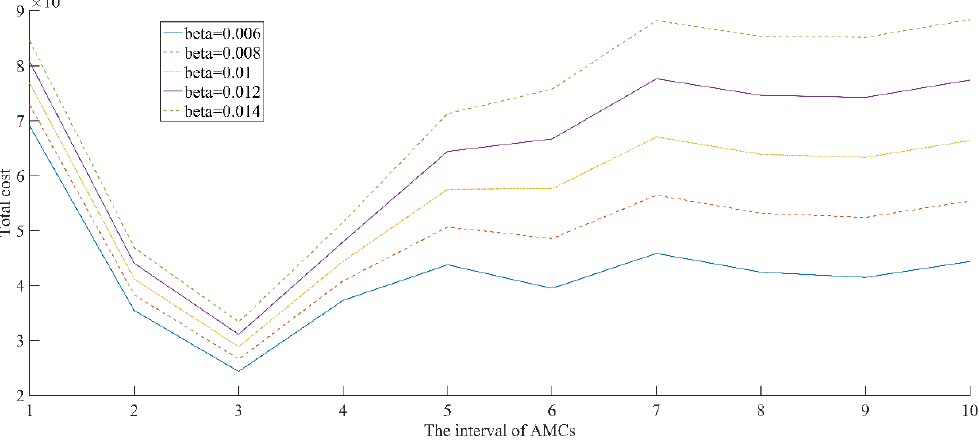
Figure 7. Expected total cost C vs. A for M m = 10 6 , M 0 = 10 4 , r = 0.5, α = 1, C A 1 = 5000, C A 2 = 0.04 and C P = 7, as well as for different values of β .